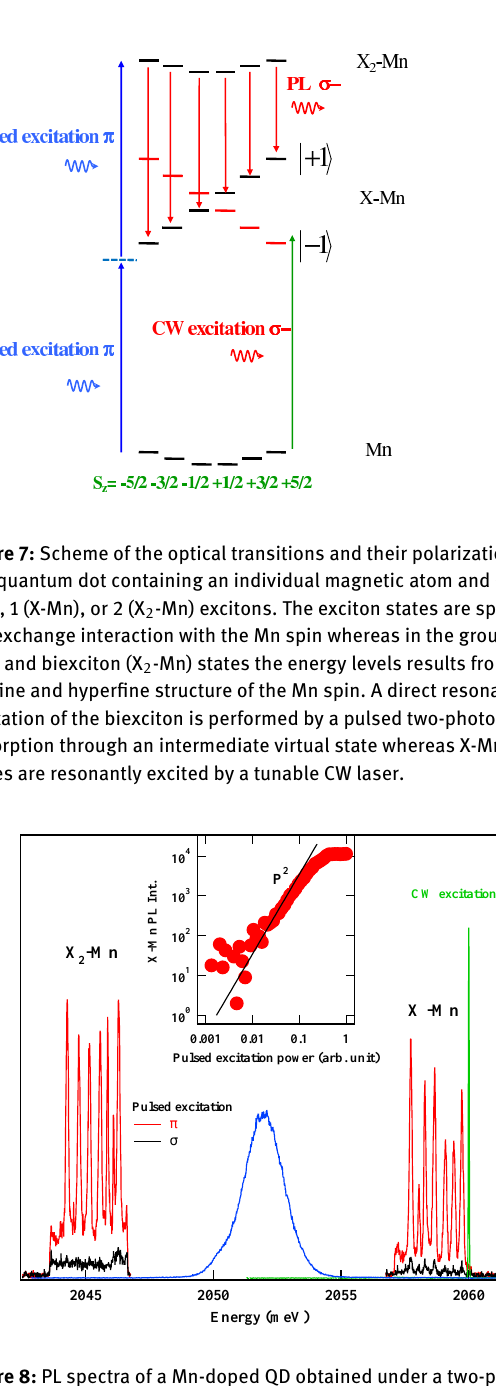
Figure 8: PL spectra of a Mn-doped QD obtained under a two-photon resonant absorption of a picosecond laser pulse (spectra of the pulsed laser in blue). The resonant creation of the biexciton (X 2 -Mn) is only possible for a linearly polarized excitation (red) whereas al- most no PL is observed for circularly polarized pulses (black). The influence on the Mn spin population of a CW control laser (spectra of the CW laser in green) in resonance with the exciton (X-Mn) lev- els can be detected in the intensity distribution of X 2 -Mn. Inset: PL intensity of X-Mn versus the intensity of the pulsed linearly polar- ized excitation. The P 2 dependence is characteristic of a two-photon